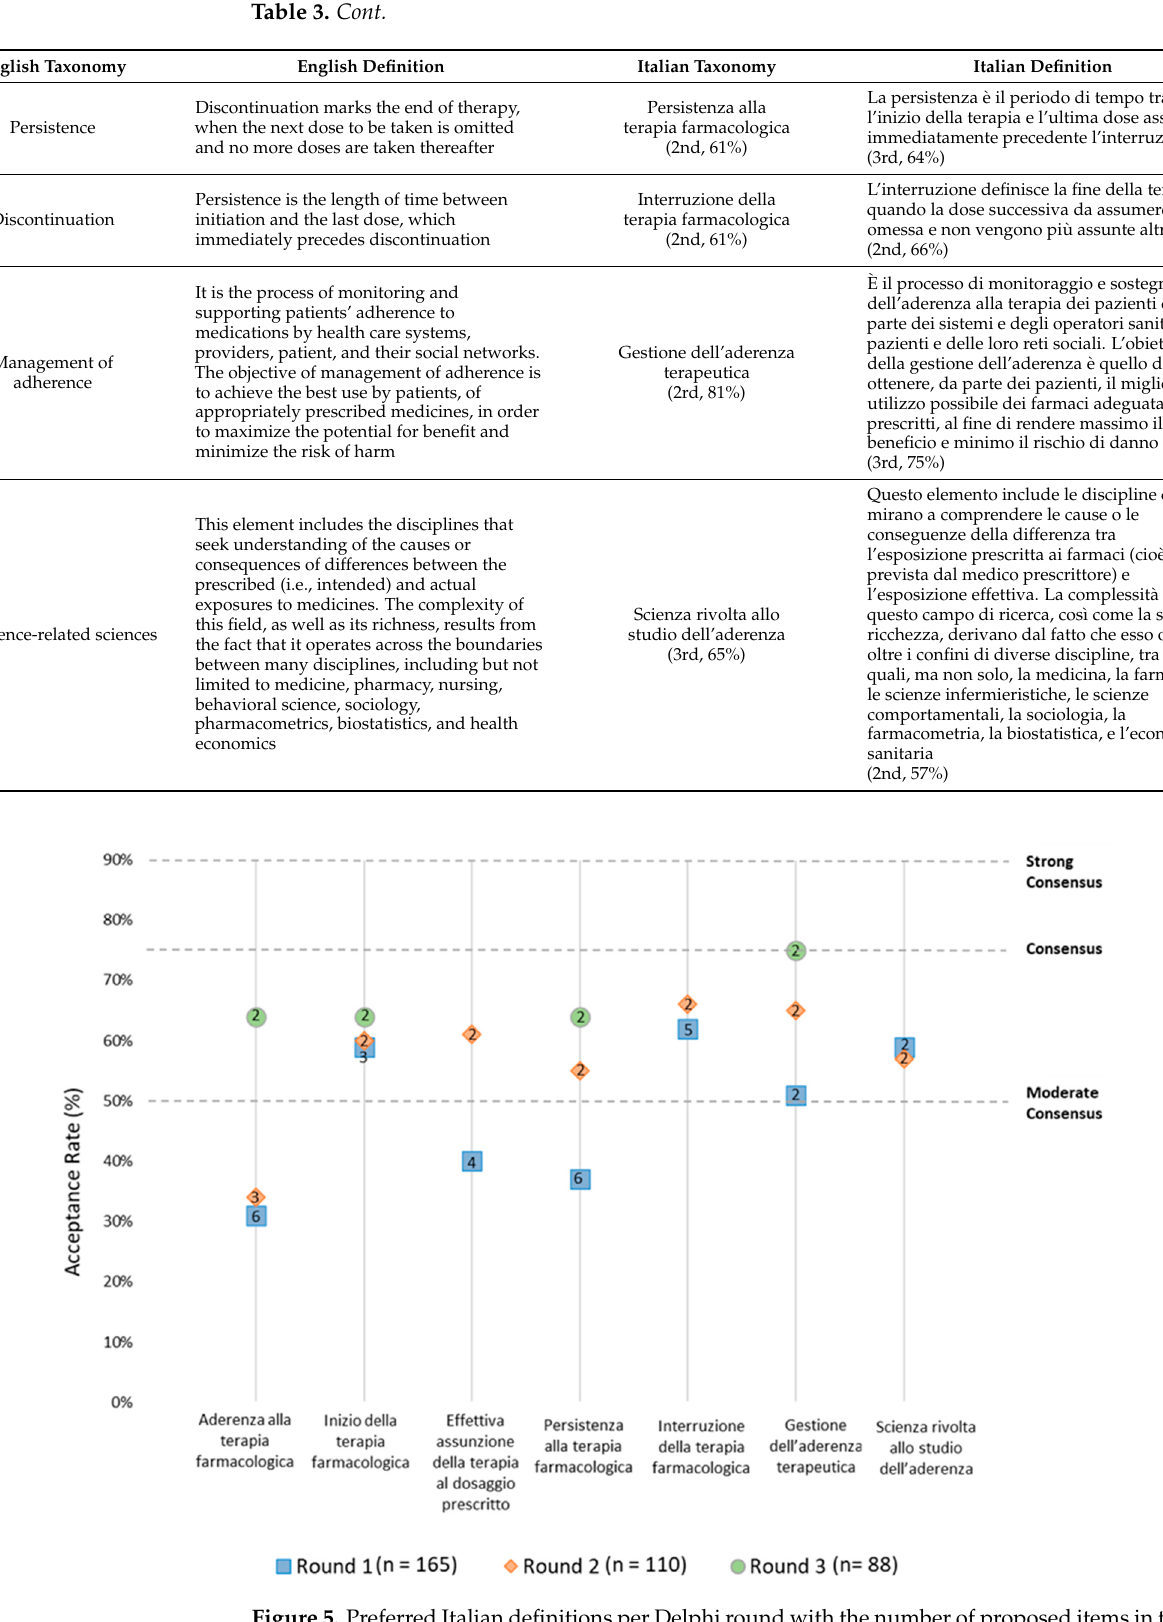
Figure 5. Preferred Italian definitions per Delphi round with the number of proposed items in the icon (numbers in the boxes are representing the amount of different translations proposed for each